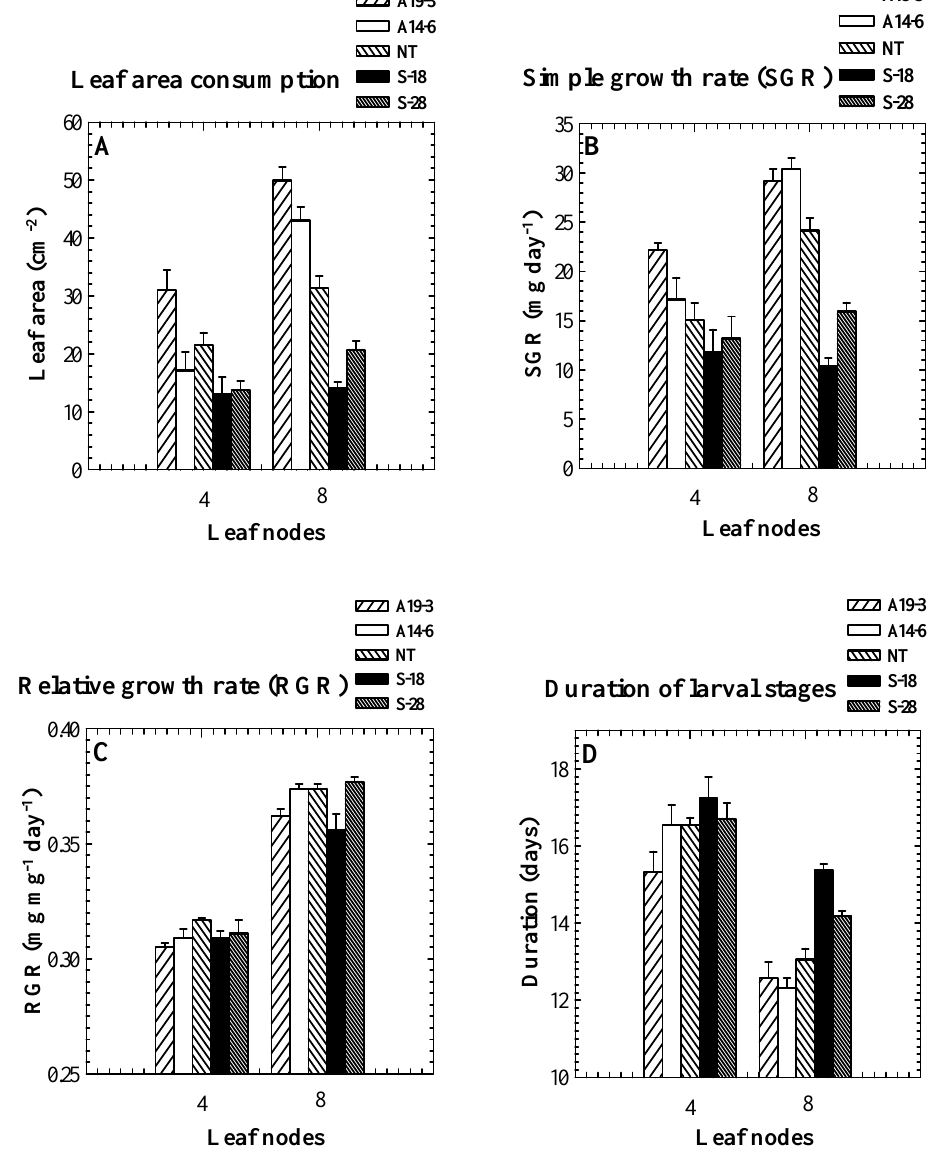
Figure 2. Leaf area consumption (A) and simple growth rates (B) of beet armyworms ( Spodoptera exigua ) feeding on nodes 4 and 8 leaves of tomato vary in different genotypes differing in PPO activity levels. Relative growth rates (C) are not related to PPO activities. Durations of larval stages (D) of beet armyworms are similar among genotypes when fed on node 4 leaves, but are extended on OP plants and attenuated on SP plants compared to controls when fed on node 8 leaves. Results are presented as means ± SE. Leaf node 1 is closest to the